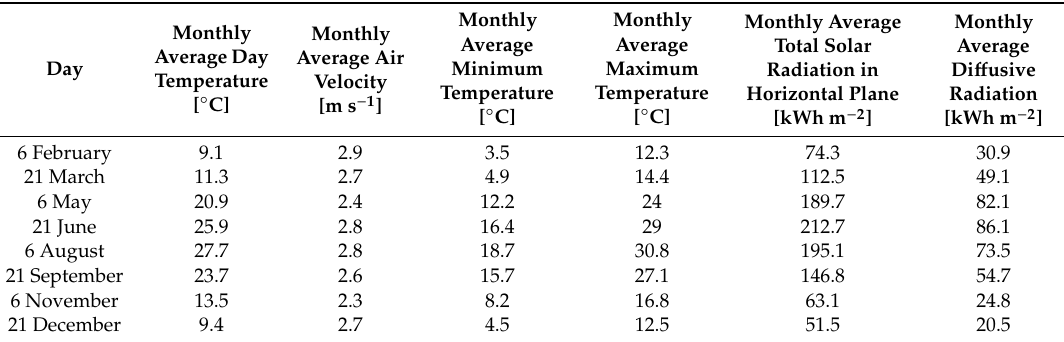
Table 7. Climatic data parametric investigation.